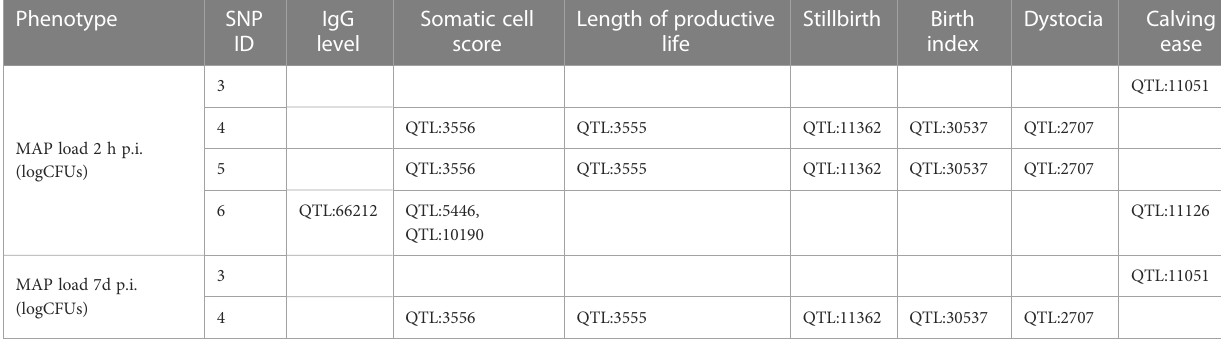
TABLE 4 Overlapping of the identi fi ed SNPs with QTLs associated with other health and reproductive traits.